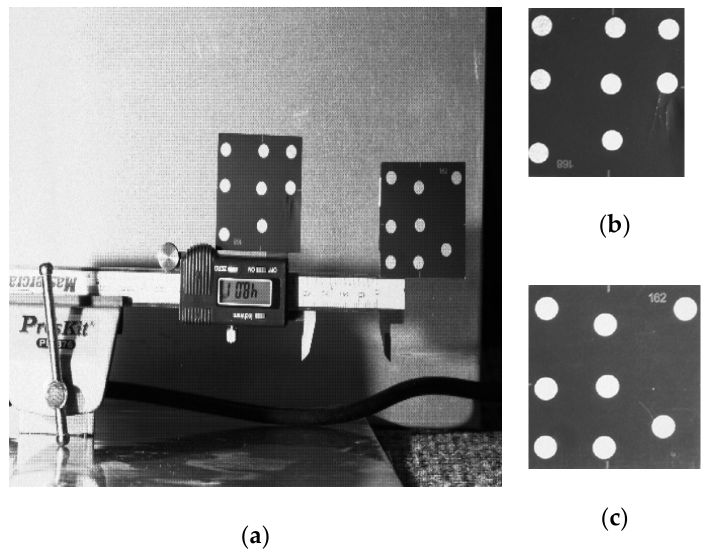
Figure 3. Calibration test off-site images are shown in ( a ) while the matching templates are shown in ( b ) and ( c ).